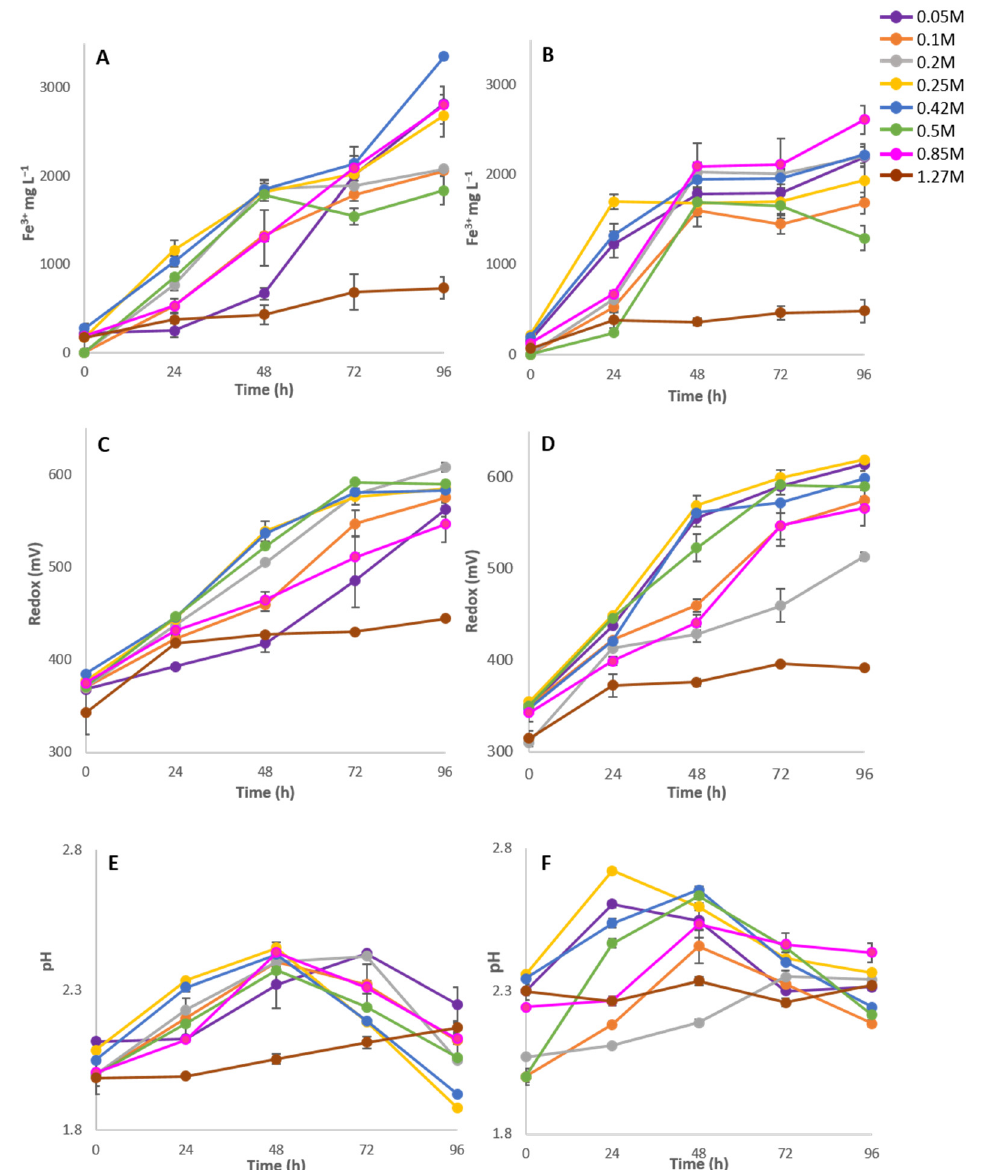
Figure 1. Ferric iron concentration, Redox potential and pH under increasing concentrations of NaCl ( A , C , E ) or MgSO 4 ( B , D , F ) in Acidihalobacter aeolianus . Values are the average of biological triplicates and include the standard error.